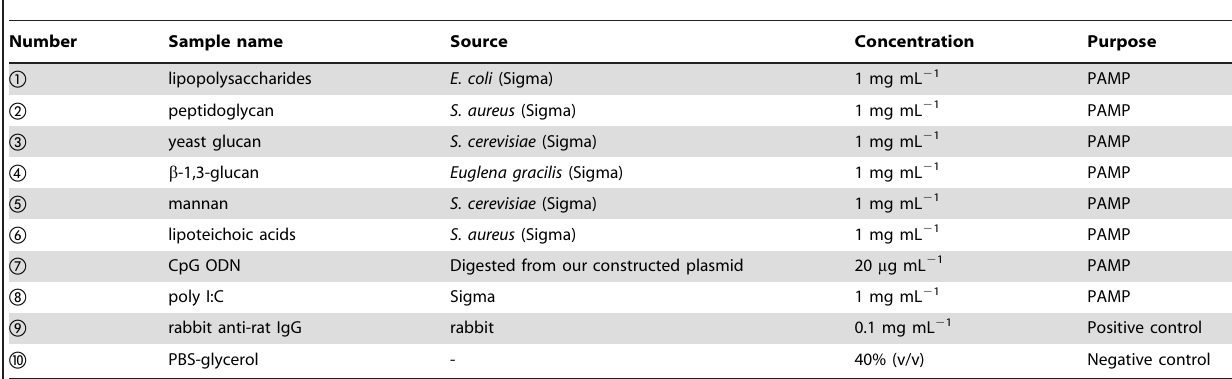
Table 2. Characteristic of the samples print on the microarrays.